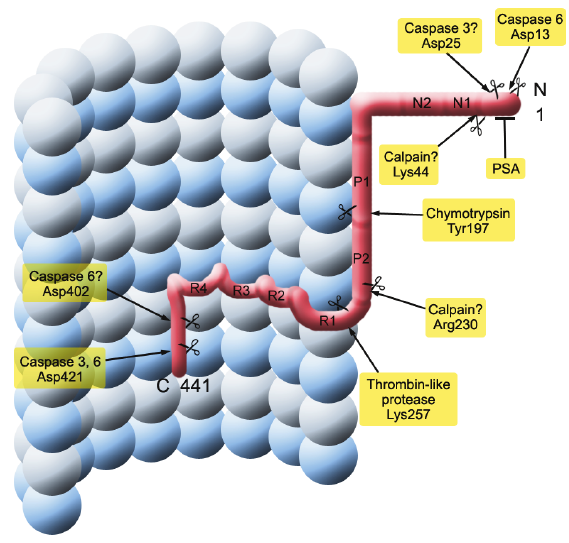
Figure 5. Diagram showing sites for potential cleavage of tau protein. The sequential cleavage of the tau protein leads to the formation of the tau protein fragment from the microtubule-binding repeat region (see text and Figure 4). Tau cleavage is more likely to take place while protein is unbound to microtubules, either aggregated to itself or associated with proteins other than tubulin. PSA = puromycin-sensitive aminopeptidase.